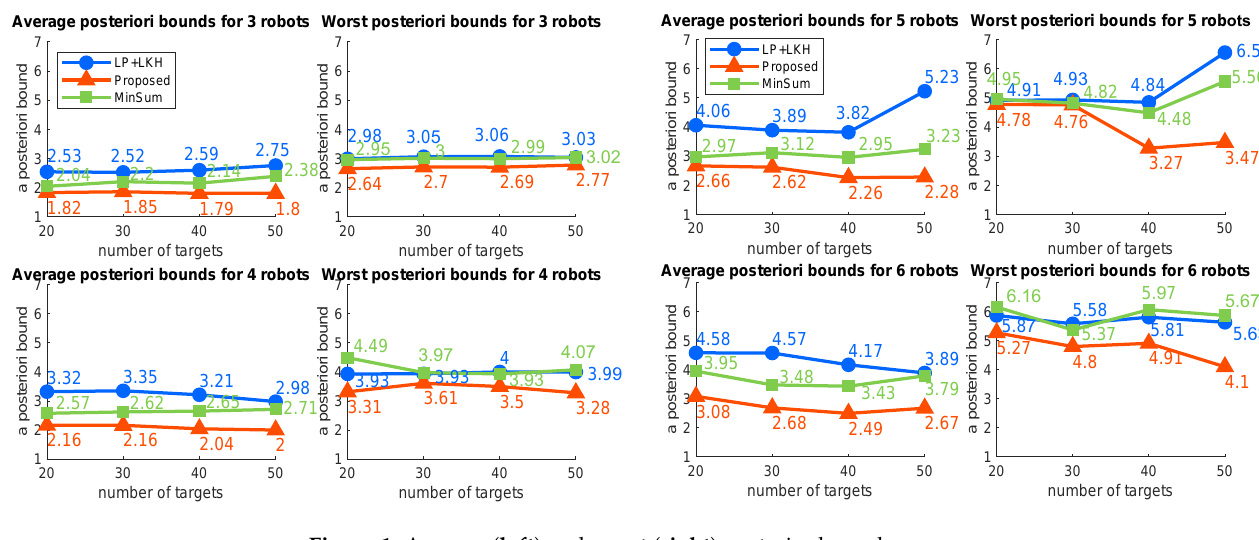
Figure 1. Average ( left ) and worst ( right ) posterior bounds.